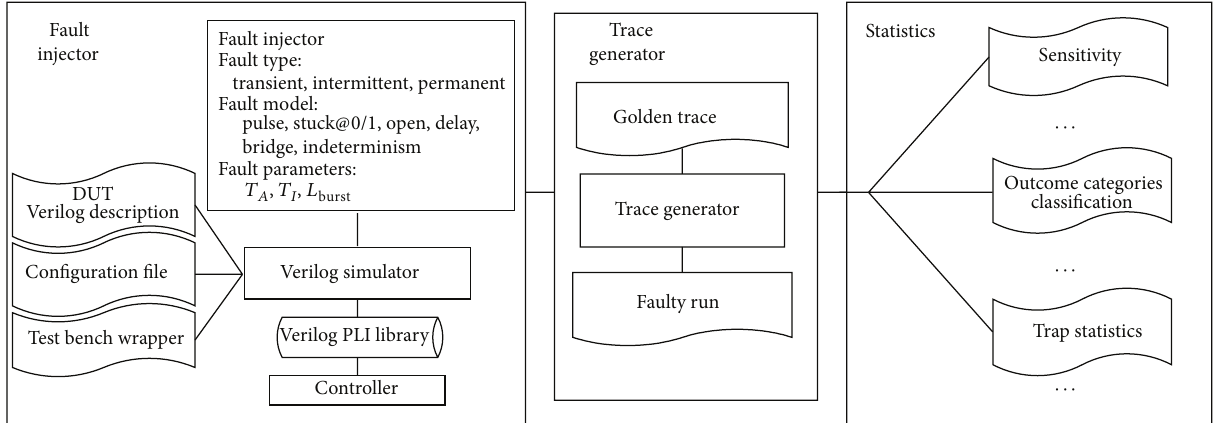
Figure 1: PFIT (Verilog PLI based fault injector)